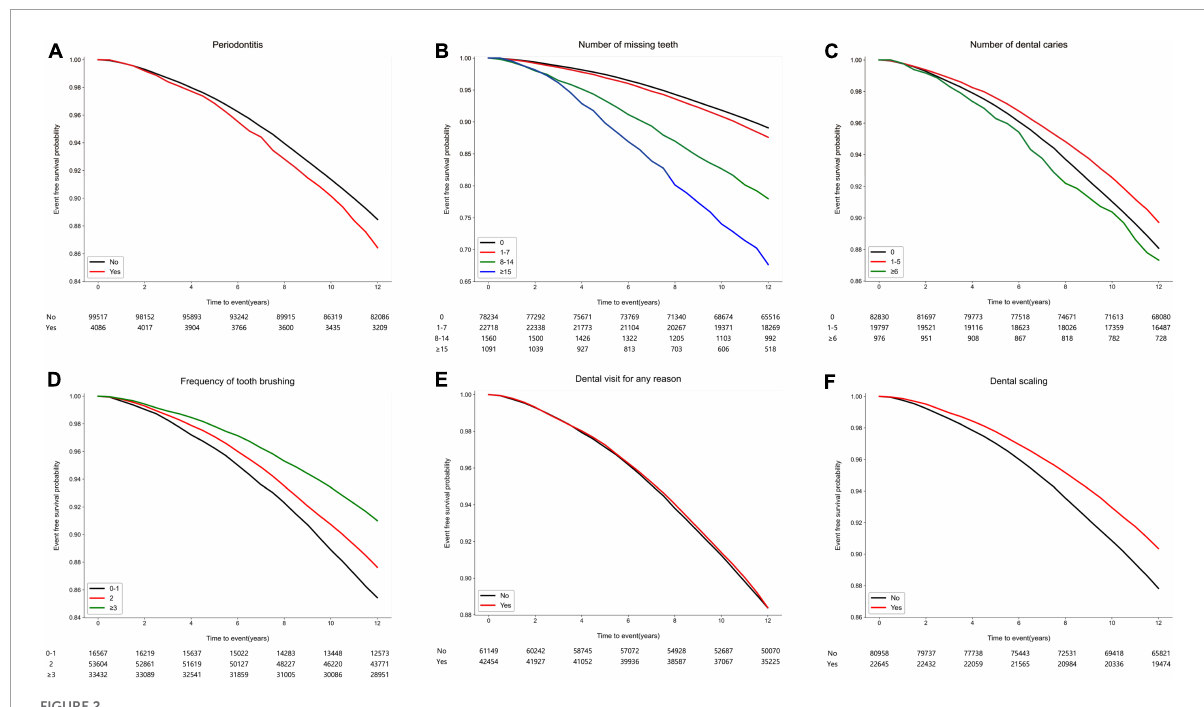
FIGURE2 Kaplan–Meier survival curves free from cataract according to oral health status and oral hygiene behaviors. (A) Periodontitis ( p < 0.001). (B) Number of missing teeth ( p < 0.001). (C) Number of dental caries ( p < 0.001). (D) Frequency of tooth brushing (times/per day) ( p < 0.001). (E) Dental visit for any reason within the previous year ( p = 0.739). (F) Dental scaling within the previous year ( p <